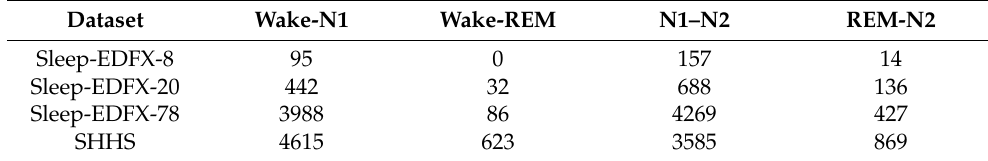
Figure 8. Sleep staging of SC4191E0 in Sleep-EDFX78. Table 2. Number of transitions from Wake to N1 and REM and transitions from N1 and REM to N2.